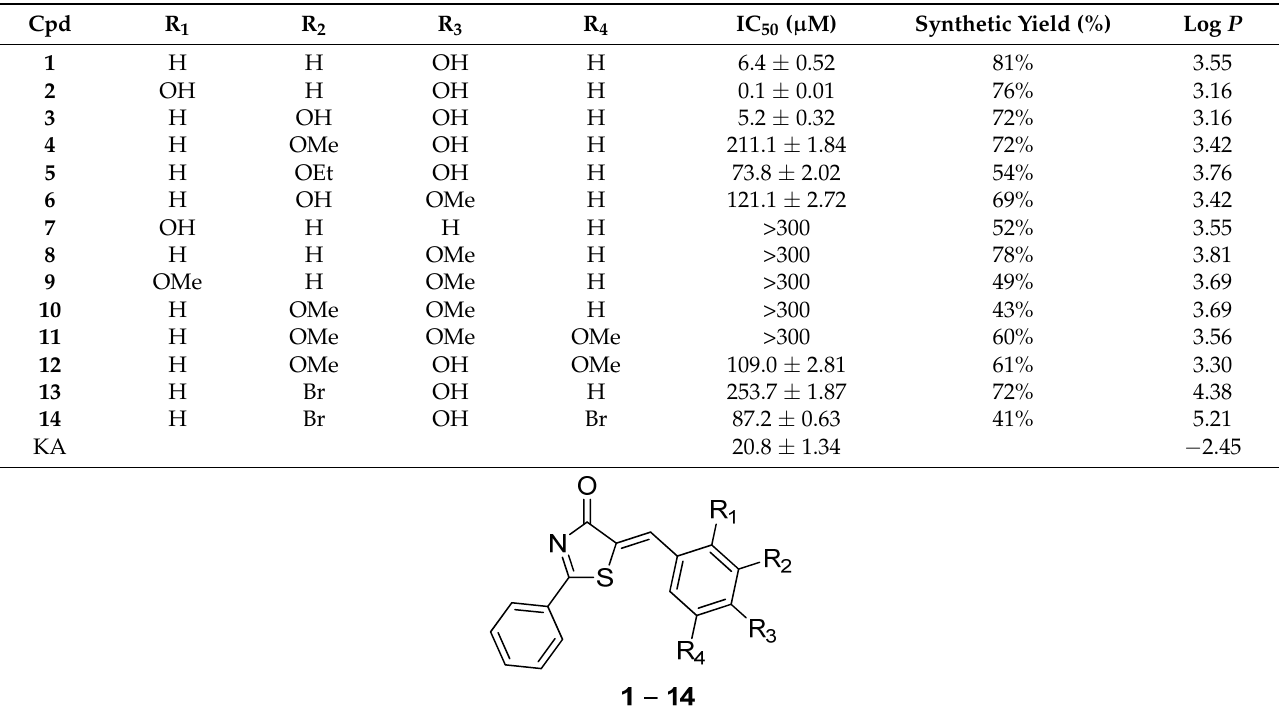
Table 1. The IC 50 values and synthetic yields of ( Z )-BPT derivatives against mushroom tyrosinase and log P values.